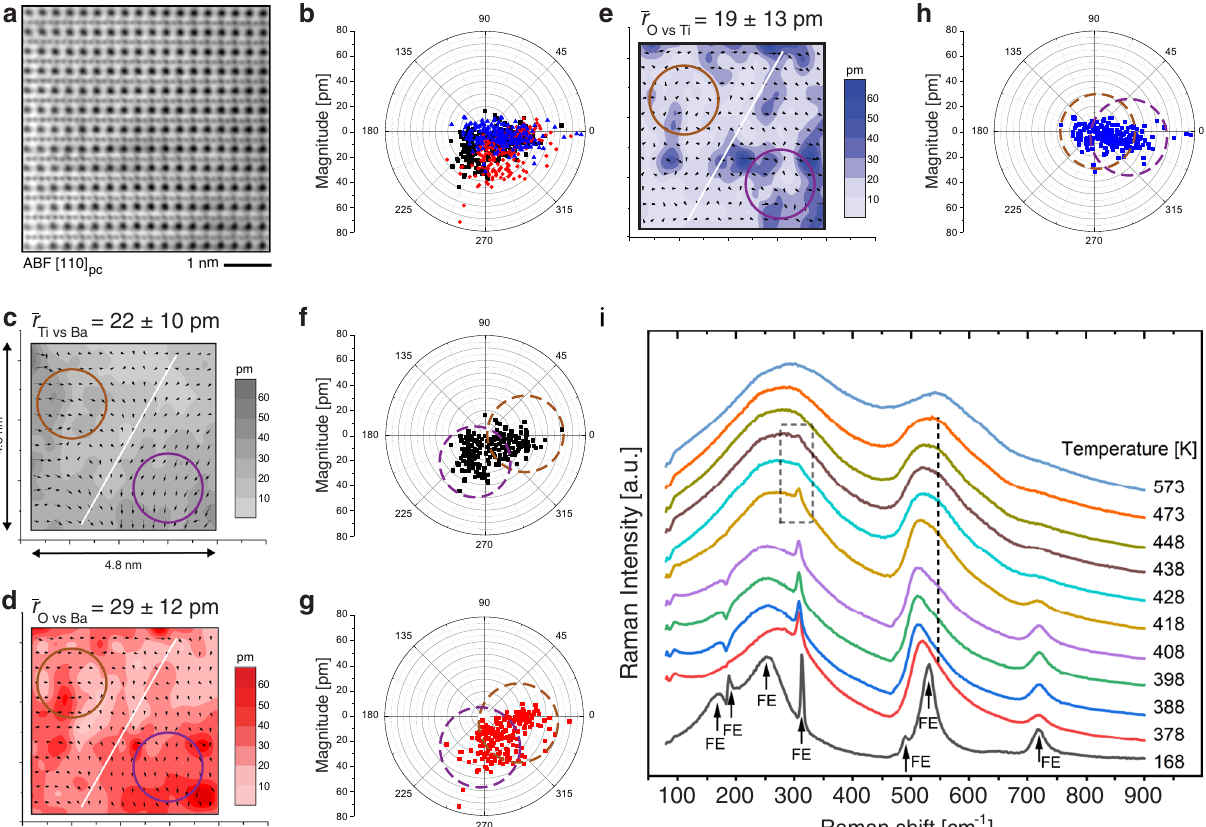
Fig. 4 Atomic displacements and Raman analysis of BaTiO 3 at 473 K. a ABF image of cubic phase of BaTiO 3 viewed along the [1 1 0] pc zone axis that was analysed to determine the displacements with b composite polar plot, which compiles data presented in c – h . The black squares represent Ti vs Ba, blue triangles O vs Ti and red circles O vs Ba displacements. c Ti vs Ba, d O vs Ba and e O vs Ti relative atomic displacements in a BaTiO 3 grain. Arrows represent the direction and magnitude of the displacements (see the colour scale on the right of each image). The interface between the two polar nanoclusters is indicated by the diagonal lines. The brown and violet full circles indicate representative areas of each cluster. f – h The same data as in c – e , respectively, presented in polar plots, delineating the orientation of the atomic displacements. Each symbol and its position in the polar plot correspond to one arrow. Dashed brown and violet circles are guides to eye to indicate two polar nanoclusters. i Raman spectra of BaTiO 3 as a function of temperature. First-order phonon modes associated with the ferroelectric phase (FE) are indicated by arrows and (e.g. the mode at 300 cm − 1 , marked by dashed square) are identi fi ed up to 438 K (i.e. above T C of ≈ 403 K). From 438 to 473 K, the modes belonging to the static disorder are still present (marked by dotted line). Above 473 K, only second-order modes resembling the phonon density of states of BaTiO 3 are recorded. Hence, the static (polar) disorder is present not only in BST6040 but also in BaTiO 3 , up to at least 438 K and a transition to the dynamic (non-polar) disorder occurs >473